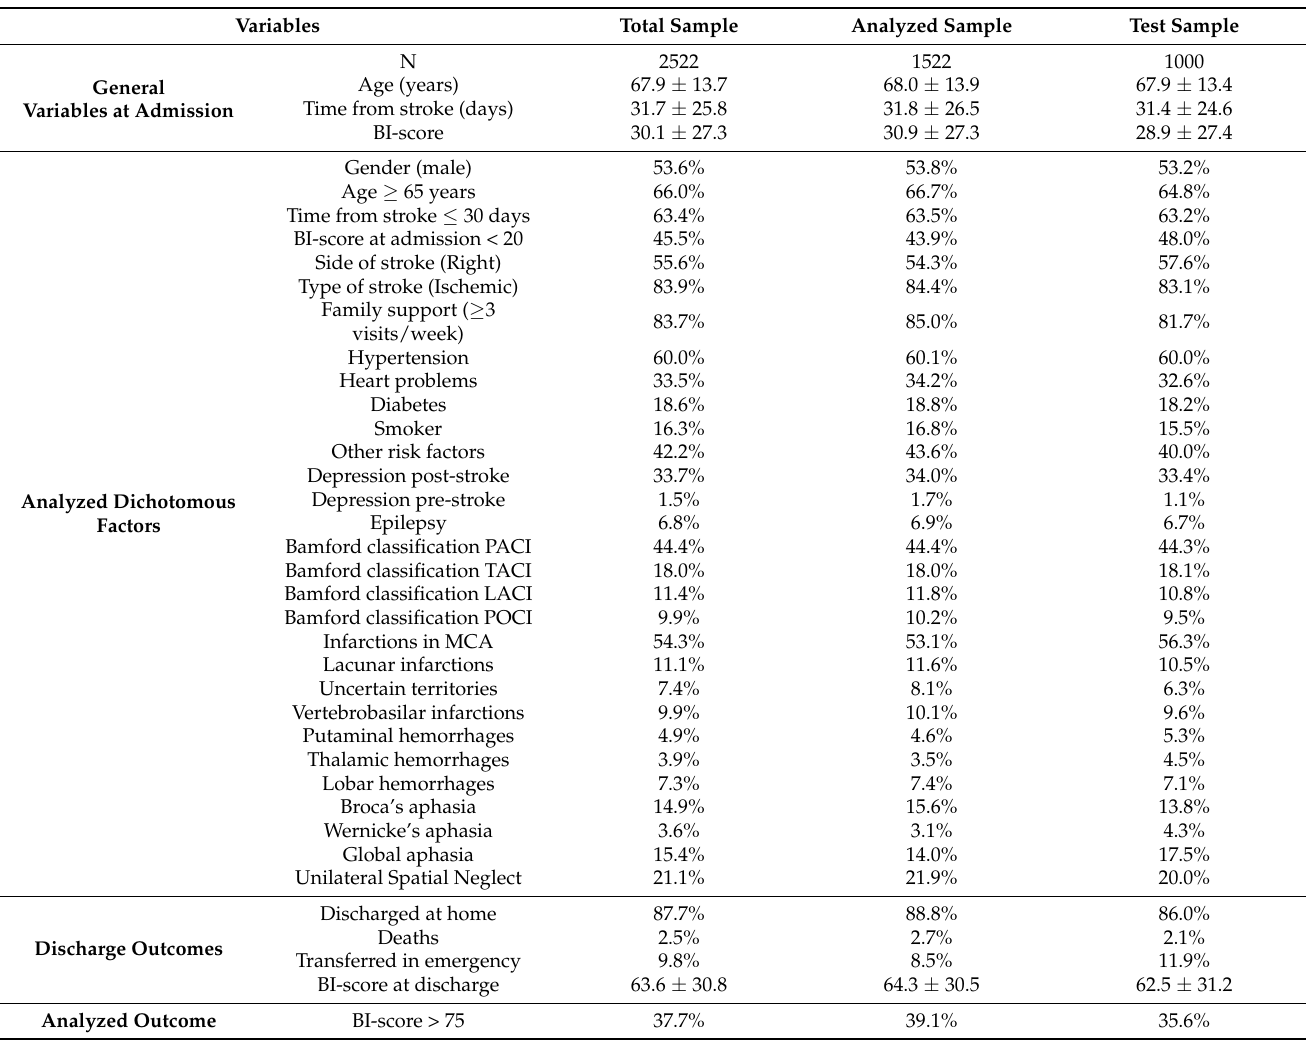
Table 1. The collected variables expressed as mean ± standard deviation or percentage relative frequency (N: number of patients, BI: Barthel Index, PACI: partial anterior circulation infarcts, TACI: total anterior circulation infarcts, LACI: lacunar infarcts, POCI: posterior circulation infarcts, MCA: middle cerebral artery